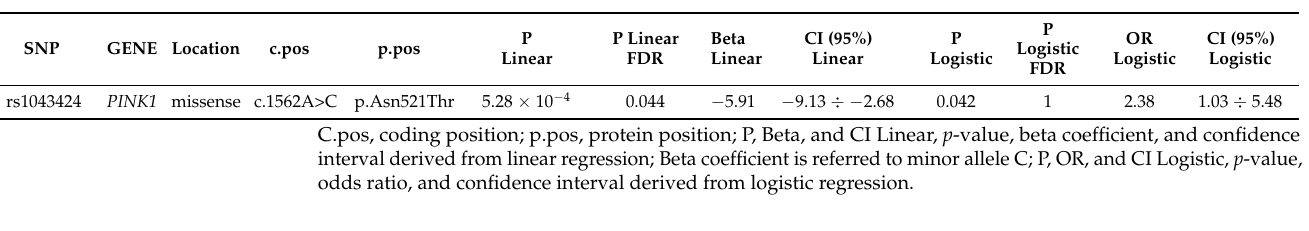
Table 3. Low frequency and common genetic variants associated with age of onset.